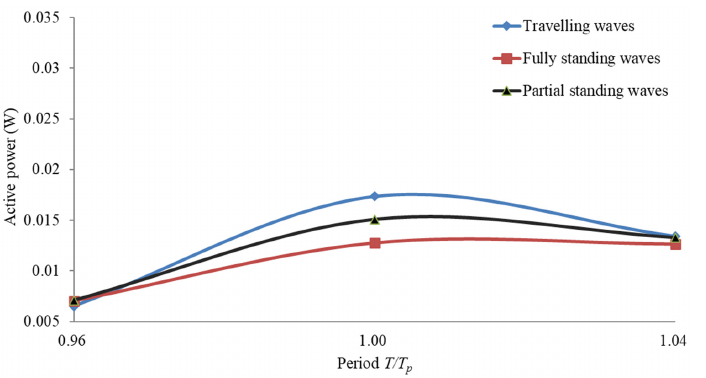
Figure 24. Comparison of generation performance under three different wave types at h = 0.7 m.